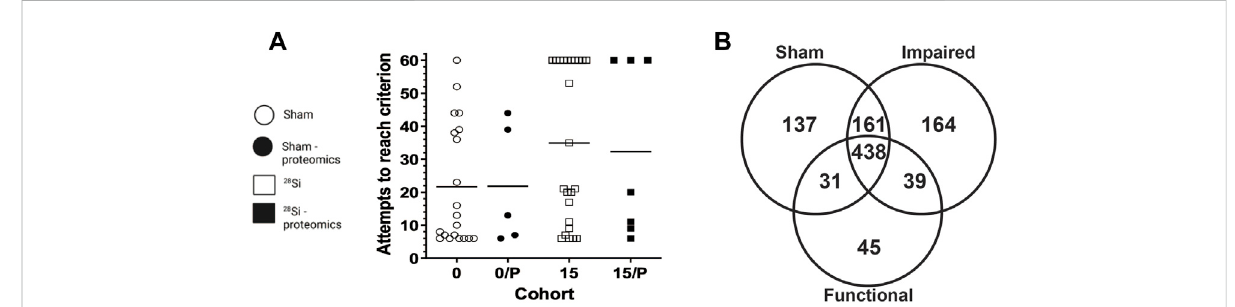
Effect of 600 MeV/n 28 Si -irradiation on performance of individual rats within the SD stage of the ATSET test (A). Individual attempts to reach completion criterion (ATRC) values for sham-irradiated rats (circles) or rats exposed to 15 cGy 600 MeV/n 28 Si (squares); horizontal bar denotes median ATRC value within a cohort. Closed symbols denotes rats that were used for the proteomic analysis. Cohort abbreviations: 0: all Sham- irradiated rats; 0/P: representative Sham-irradiated rats used for proteomic analysis; 15: all rats exposed to 15 cGy 600 MeV/n 28 Si; 15/P: rats exposed to 15 cGy 600 MeV/n 28 Si rats used for proteomic analysis. The Venn diagram (B) shows the number of proteins detected in the various